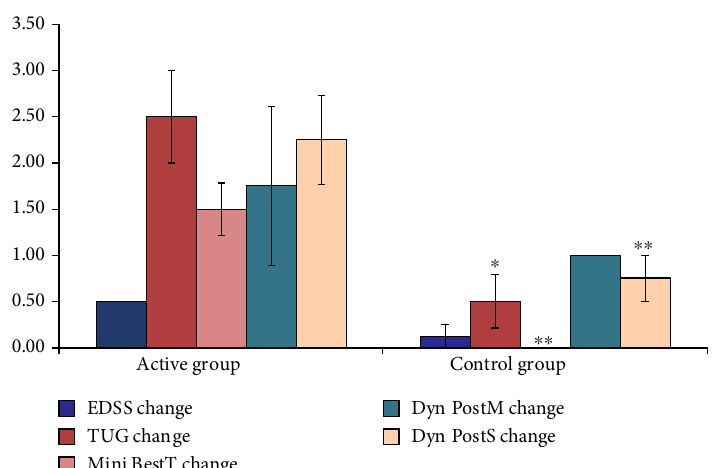
Figure 4: Comparison between severe active group and severe control group as regard to all the studied variables. SD: standard deviation; ∗ P < 0 : 05 between group comparison; ∗∗ P < 0 : 01 .